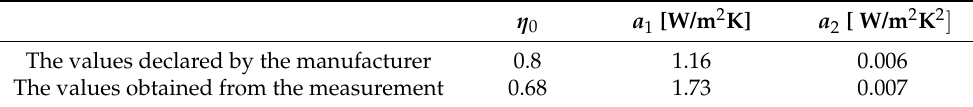
Table 4. Coefficients of thermal efficiency characteristics of a solar collector.